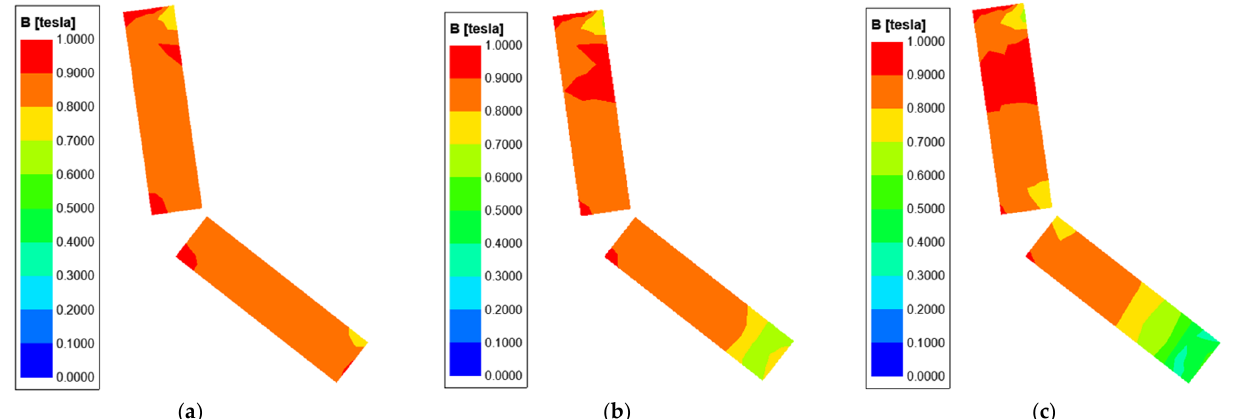
Figure 5. Magnetic flux density of the permanent magnets after the demagnetization: ( a ) 5 times, ( b ) 6 times, and ( c ) 7 times higher than the rated current.